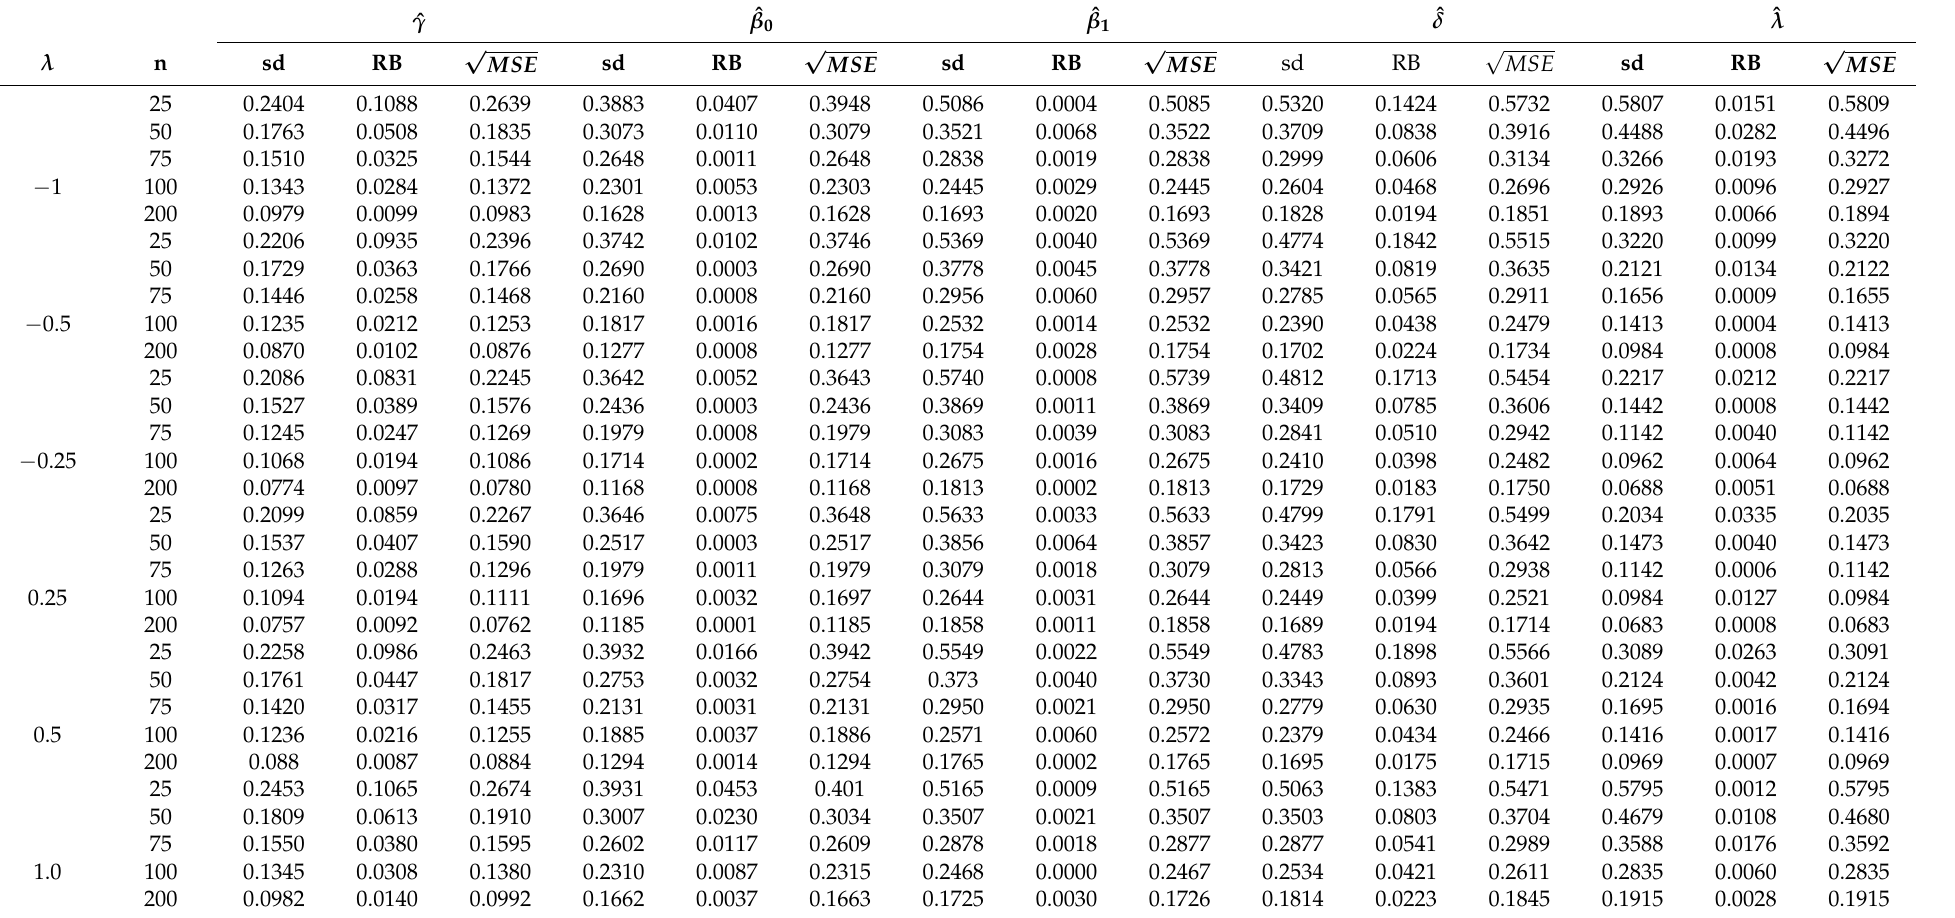
√ MSE for the FSHN ( 1,1.75,1.25, − 1.5, λ )